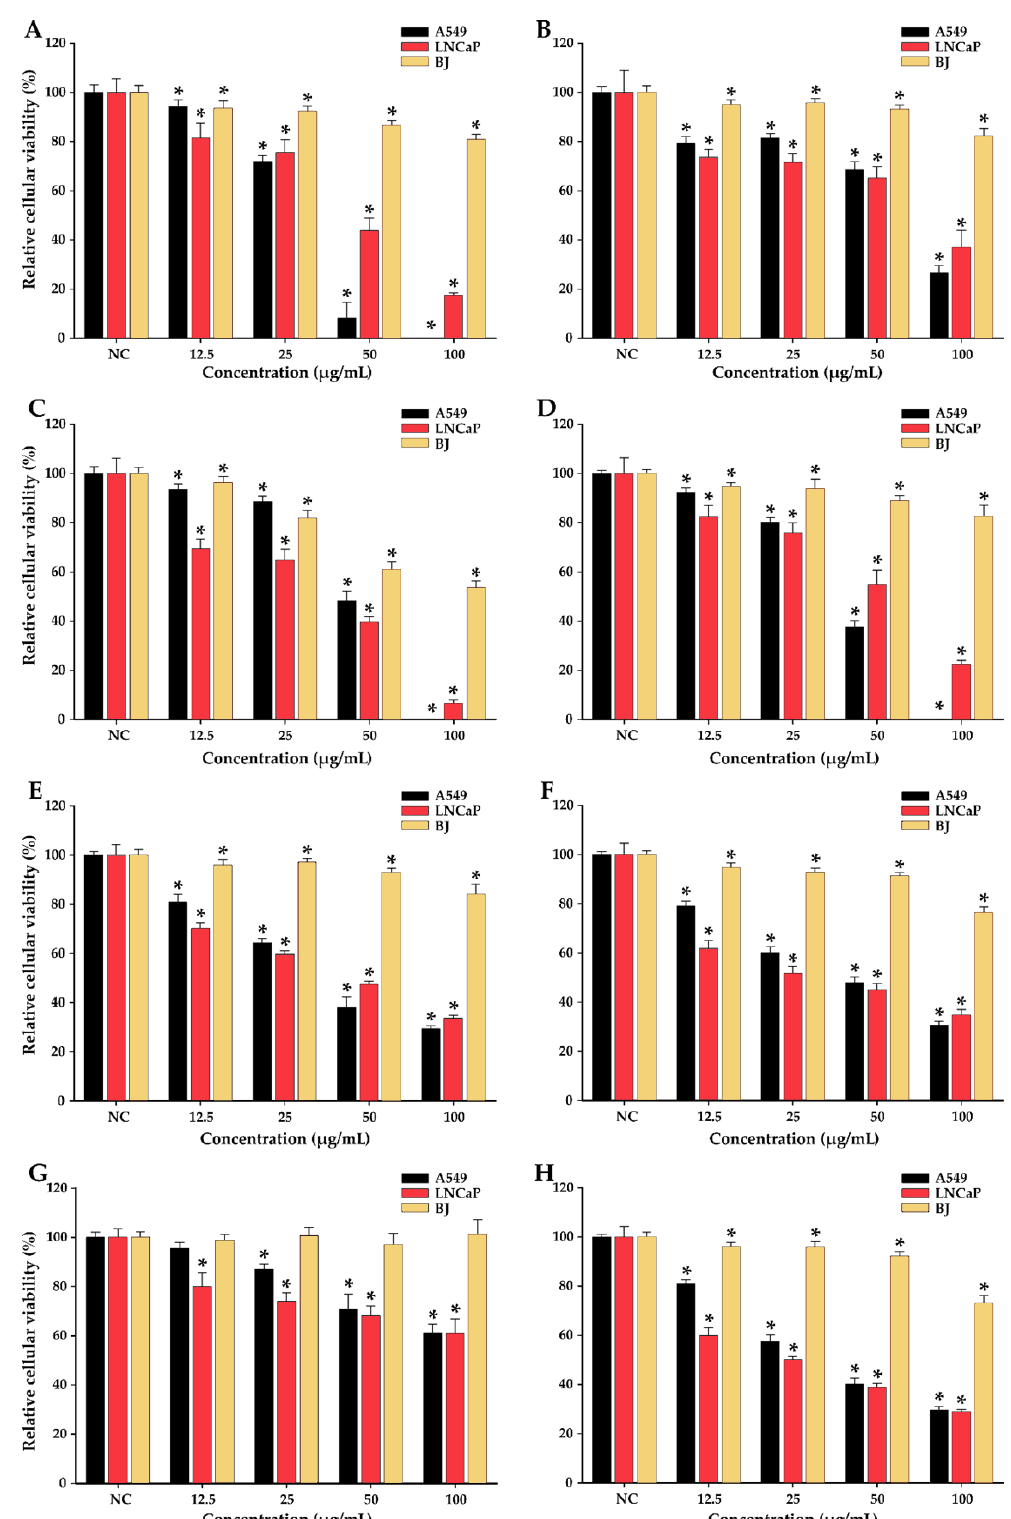
Figure 2. Cytotoxic effect of 5a ( A ), 5b ( B ), 5c ( C ), 5d ( D ), 6a ( E ), 6b ( F ), 6c ( G ) and 6d ( H ) after 24 h exposure on A549, LNCaP and BJ cells. The results are presented as relative means ± standard deviations of three biological replicates (six technical replicates for each biological replicate). Viability data were expressed as relative values, where the negative control (NC) is 100%. Asterisks (*) indicate significant differences ( p < 0.05) compared to NC.